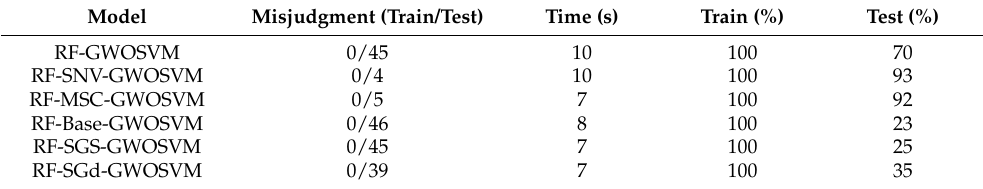
Table 9. The Ranman spectra after five different pretreatments are extracted using the random forest algorithm, and the GWO-SVM classification models are established using the extracted feature